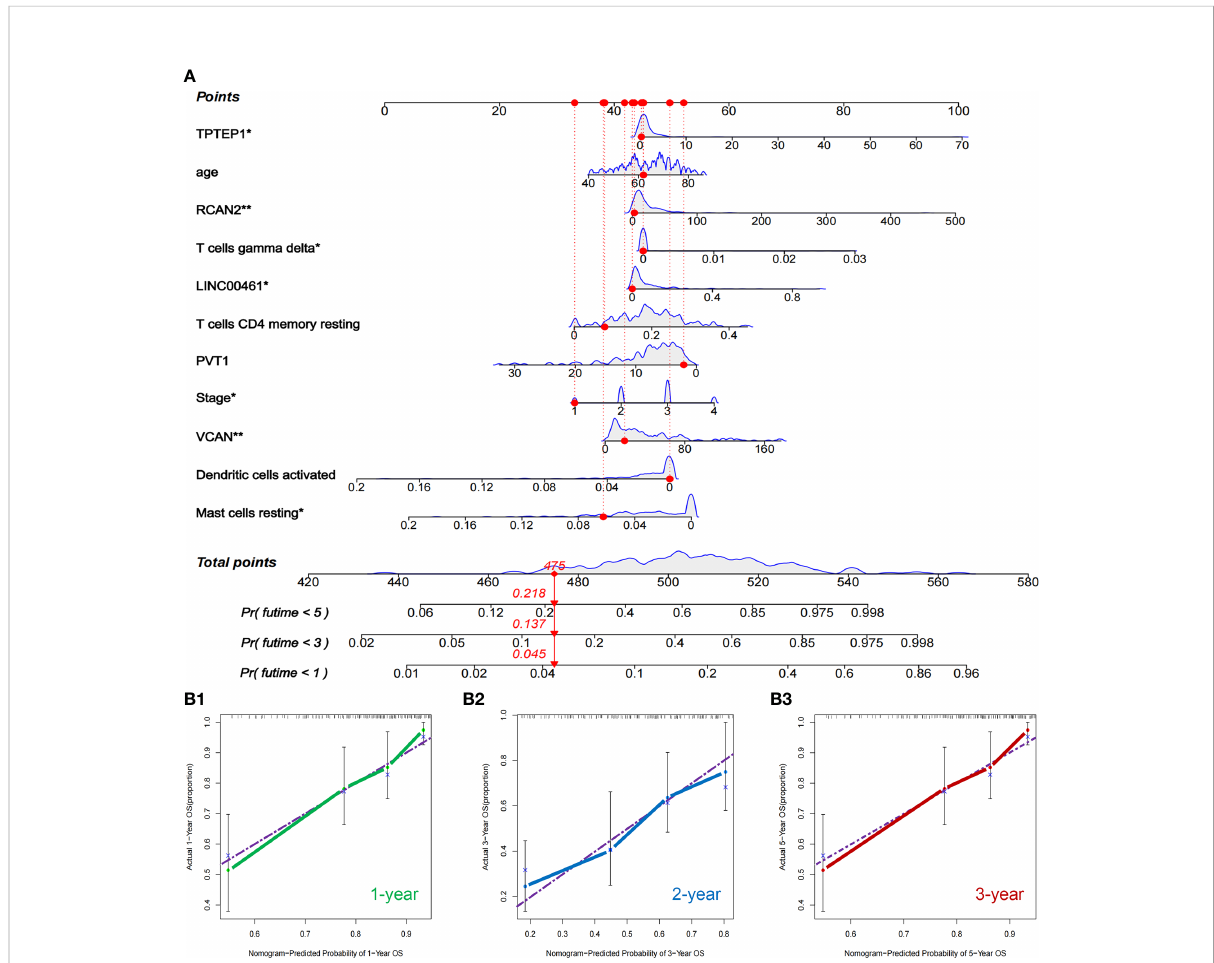
FIGURE 9 Nomogram and validation of comprehensive prognostic model. (A) Nomogram of the comprehensive prognostic model. (B1 – 3) The calibration curves for the nomogram.